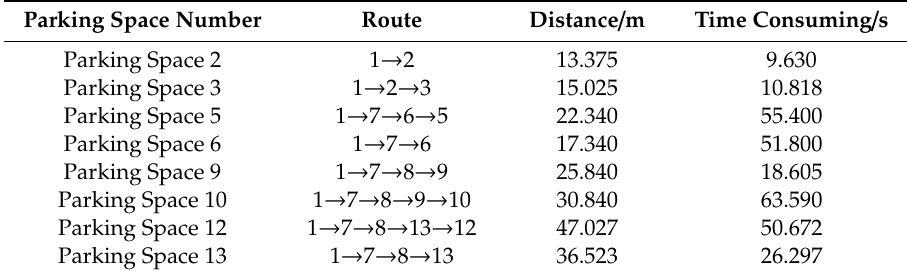
Table 6. Initial driving route of each parking space.